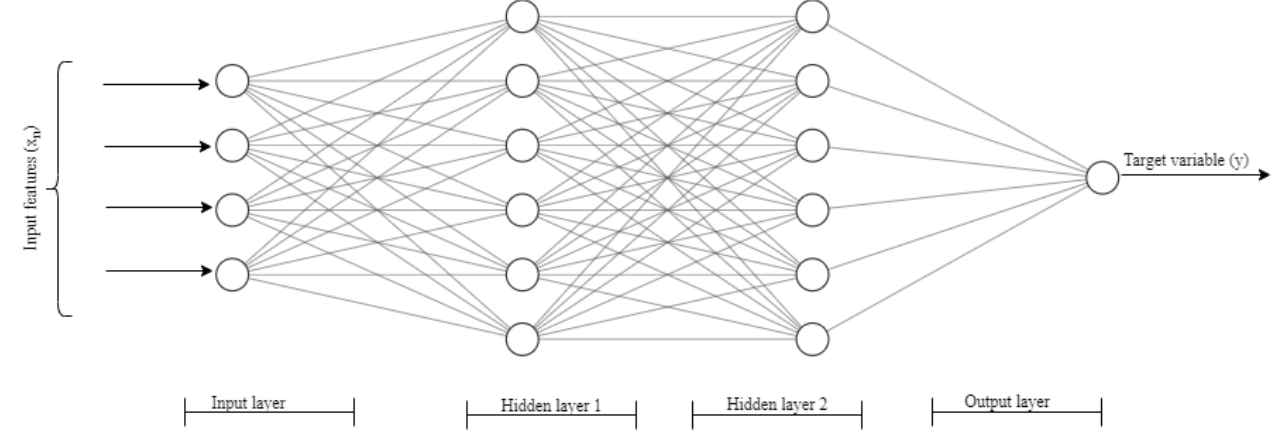
Figure 3. The schematic representation of a four-layered ANN model.